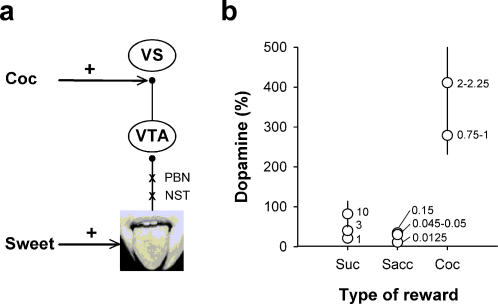
Effects of sucrose, saccharin or cocaine consumption on ventral striatal dopamine levels.a, Consumption of sweet solutions turns on midbrain dopamine cells that projects to the ventral striatum, possibly through a short, two-relay circuit in the brain stem [80]. In contrast, cocaine directly increases dopamine levels in the ventral striatum by blocking dopamine uptake. The symbol+indicates pharmacological or sensory stimulation and the symbol x, intermediate synapses. NST, nucleus of the solitary tract; PBN, parabrachial nucleus; VS, ventral striatum; VTA, ventral tegmental area. b, Mean (±SEM) levels of extra-cellular dopamine in the ventral striatum (expressed as percent change from baseline) during sucrose, saccharin or cocaine intake. These results are based on a meta-analysis of the literature (see Materials and Methods). Values that appear on the right of symbols represent sucrose or saccharin concentrations (in %) and cocaine doses (in mg/kg).